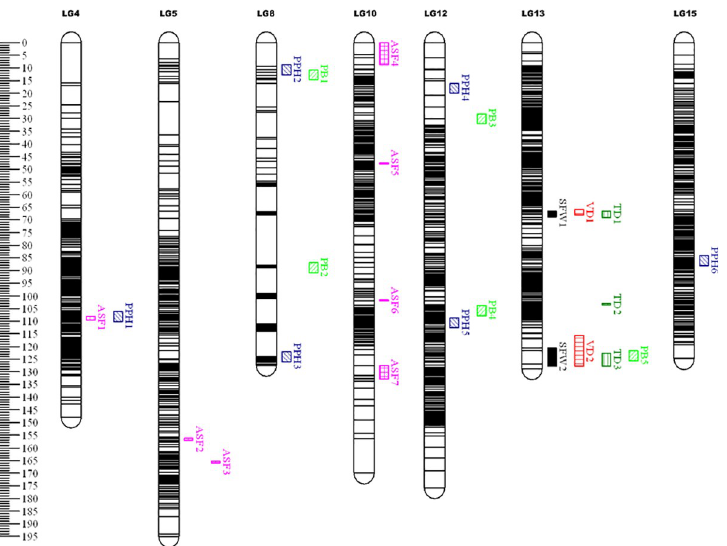
Fig 6. QTL mapping of hawthorn fruit traits. Different colors represent different traits. TD’, ‘VD’, ‘SFW’, ‘PB’, ‘PPH’ and ‘ASF’ represent ‘fruit transverse diameter’, ‘fruit vertical diameter’, ‘single fruit weight’, ‘pericarp brittleness’, ‘pericarp puncture hardness’ and ‘average sarcocarp firmness’